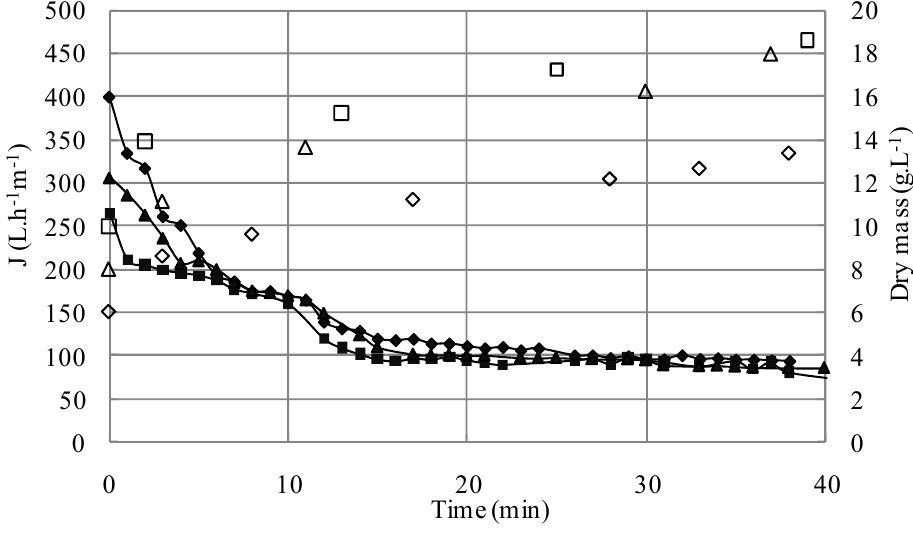
Figure 2. Effect of initial cell concentration (  S and evolution of dry mass of the retentates (  S U = 2.38 m/s, R e =